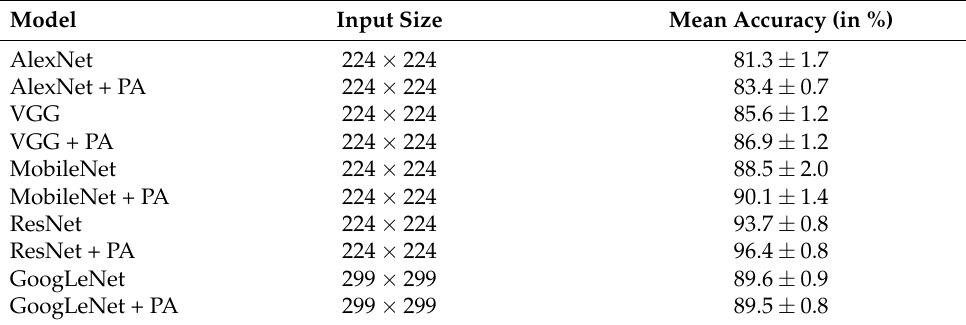
Table 1. Results on our datasets via different